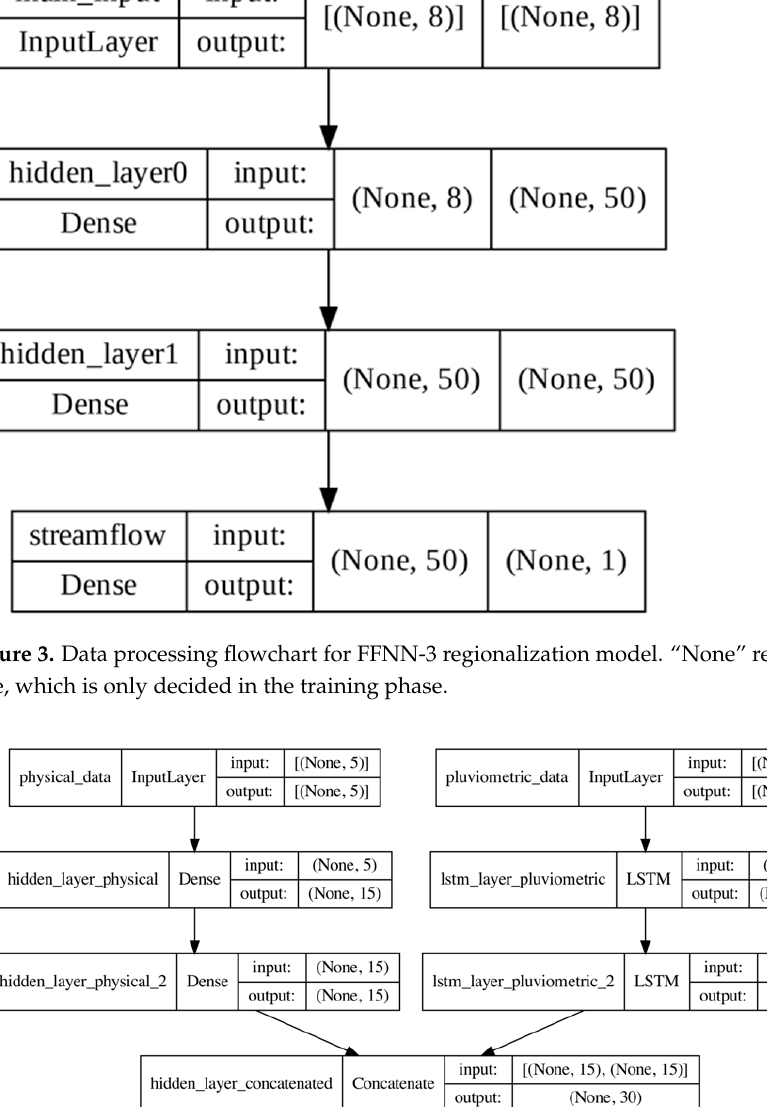
Figure 4. Data processing flowchart for the LSTM model. “None” represents the batch size, which is only decided in the training phase.